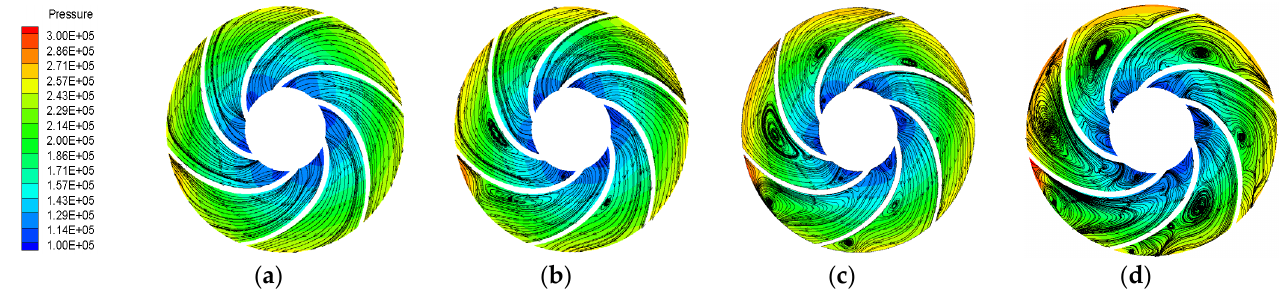
Figure 12. Pressure and streamline distribution in impeller after rapid change conditions ( a ) 0.8× Q d , ( b ) 0.6× Q d , ( c ) 0.4× Q d and ( d ) 0.2× Q d .